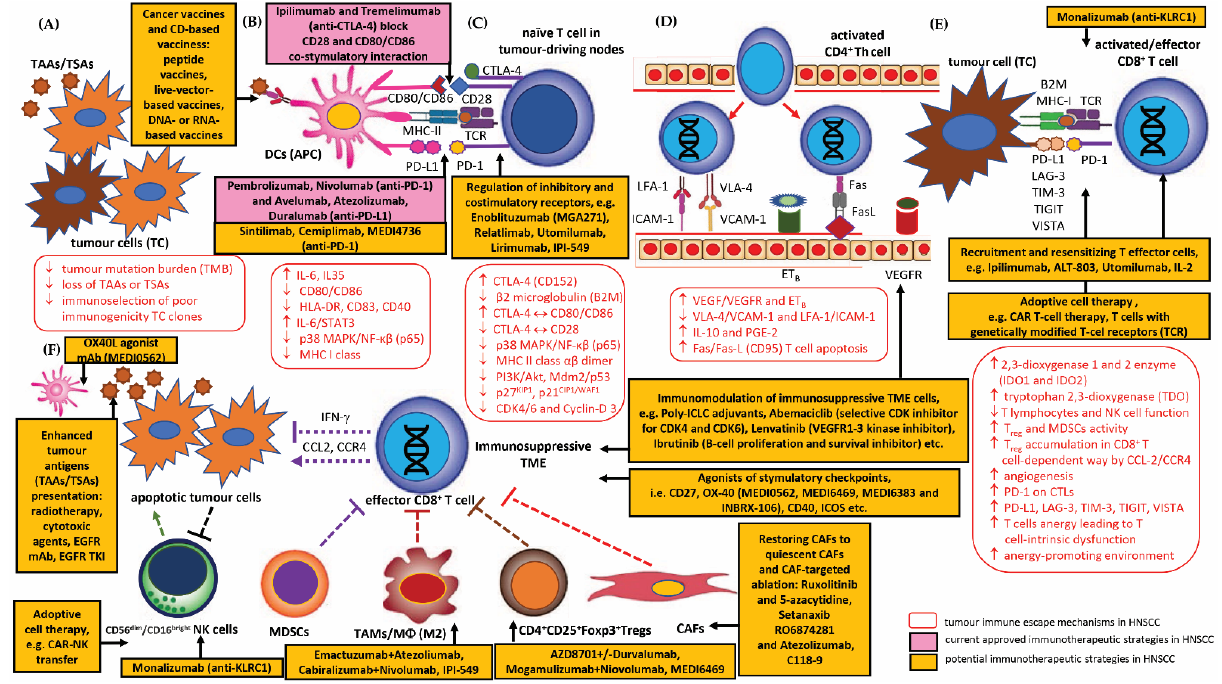
Figure 2. The crucial mechanisms of tumour immune escape and summary of current ap- proved/potential strategies to overcome immunosuppressive TME in HNSCC. ( A ) Deficiency in